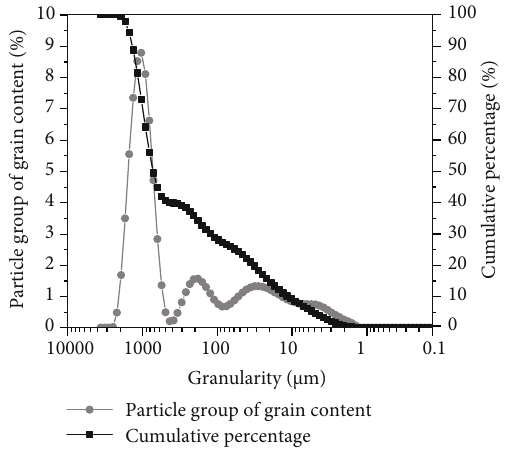
Figure 2: Grain-size distribution.